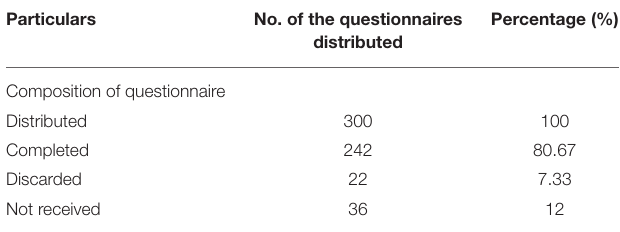
TABLE 1 | Break down of sample size.